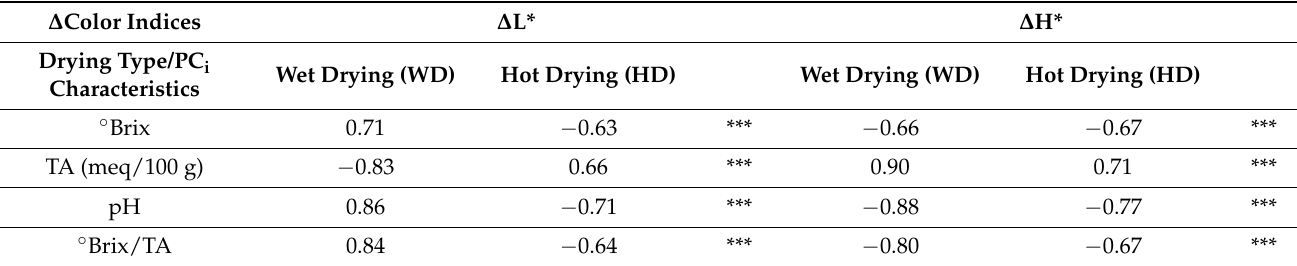
Table 1. Pearson’s correlation coefficients between the ∆ Color index of standard drying and wet or hot drying schemes for indices L* and H* and the physicochemical ( PC i ) indicators. Statistical significance between slopes of the regression lines presented in Figure 2 is indicated. ∆